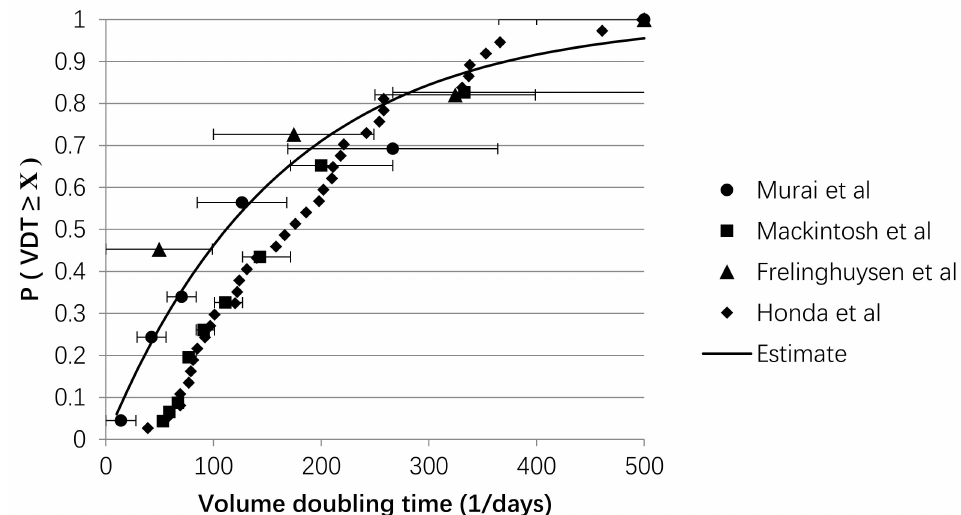
Figure 2. Estimation of the cumulative distribution function of the volume doubling time ( VDT ). VDT values found in literature were used to create the scatterplot [26–29]. A cumulative distribution function is fitted using a least square function to the data shown in this scatterplot to obtain a quantile function, which was subsequently used to determine the random tumour growth rates per